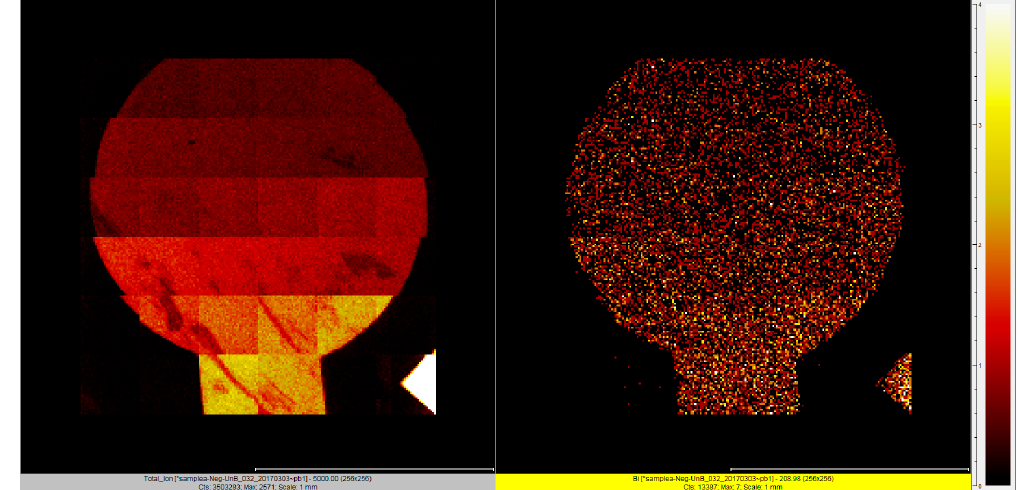
Figure 4. The total secondary ions acquired at the negative polarity of gold ( left ) and the bismuth ion image ( right ) using a Ga+ primary source.